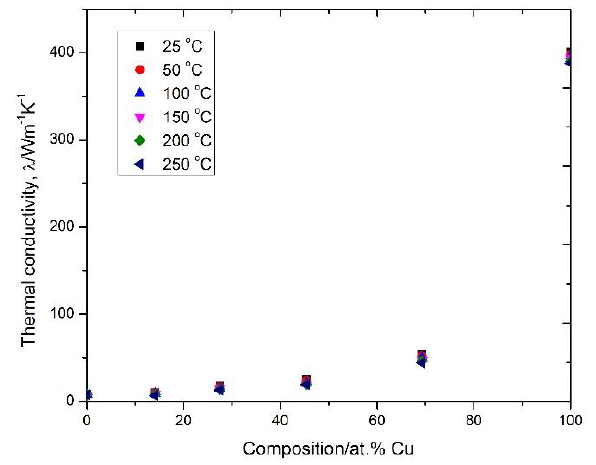
Fig. 9. Thermal conductivity dependence on composition for the investigated Bi-Cu alloys and the pure constitutive metals Bi and Cu at the studied